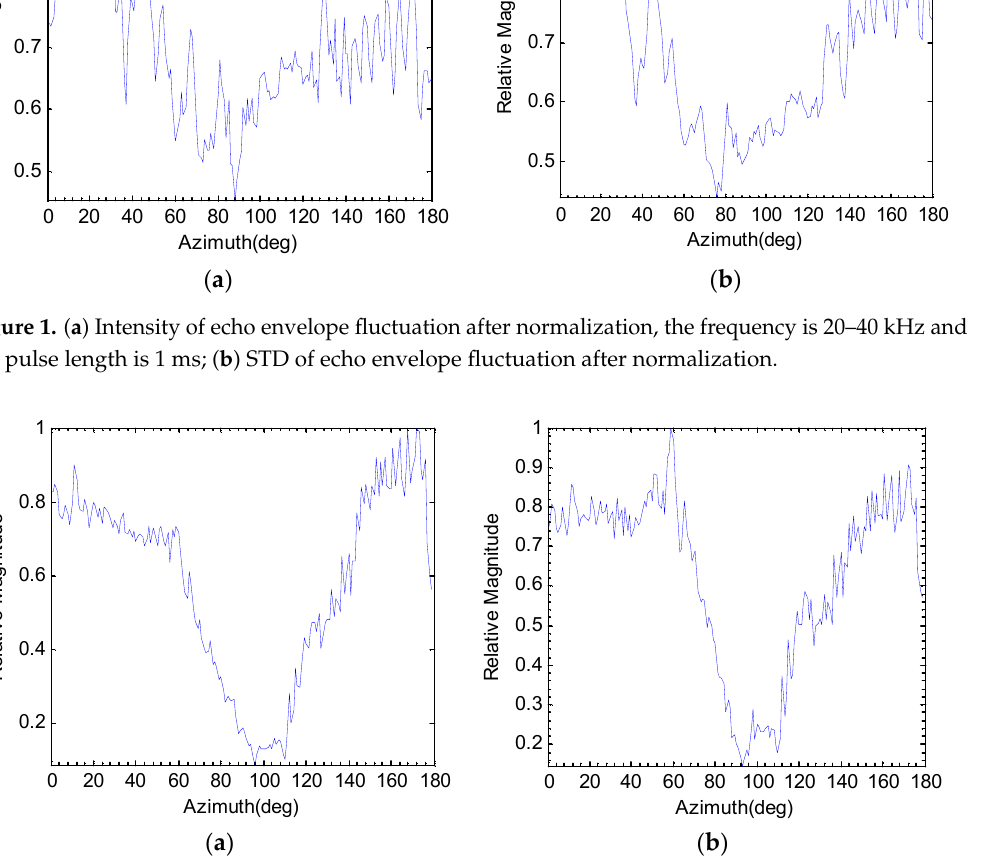
Figure 2. ( a ) Intensity of echo envelope fluctuation after normalization, the frequency is 20–40 kHz and the pulse length is 3 ms; ( b ) STD of echo envelope fluctuation after